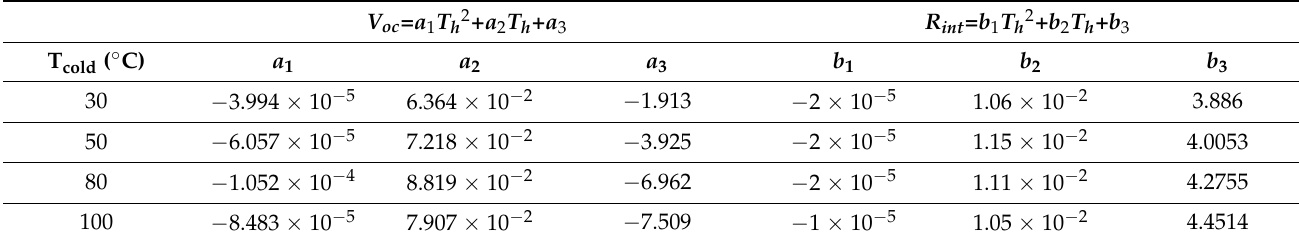
Figure 4. TEM manufacturer datasheet: ( a ) open circuit voltage vs. T h under various T c , ( b ) matched load resistance vs. T h under various T c , and ( c ) output power and output voltage vs. current under T h = 300 °C and T c = 30 °C. Table 1. Polynomial coefficients of V oc and R int . Table 1. Polynomial coefficients of V oc and R int .